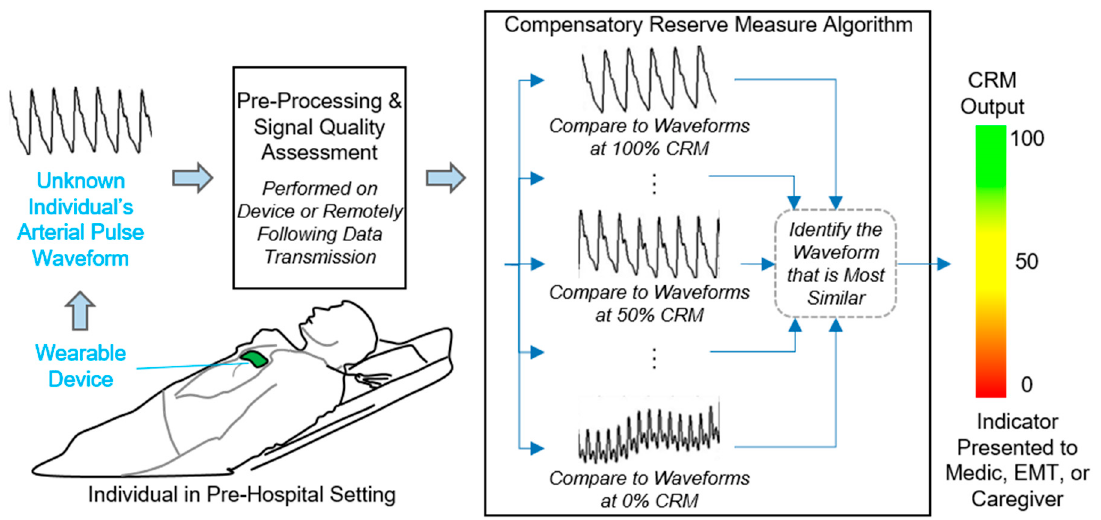
Figure 2. Illustration of changes in features of the ejected and reflected arterial waveforms progressing from a normal blood volume state to a state of reduced central blood volume (i.e., hypovolemia) such as that experienced during hemorrhage. The red line indicates the integrated waveform that is clinically observed. Modified from Convertino et al. [14,22,23].